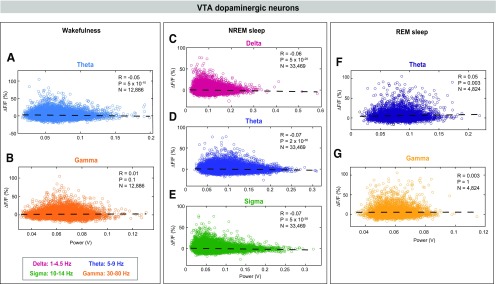
Correlations between EEG spectral components and VTA-dopaminergic neural activity during wakefulness, NREM sleep, and REM sleep. VTA-dopaminergic population activity plotted against EEG θ (A) and γ (B), power during wakefulness. VTA-dopaminergic population activity plotted against EEG δ (C), θ (D), and σ (E) power during NREM sleep. VTA-dopaminergic population activity plotted against EEG θ (F) and γ (G) power during REM sleep. Each dot represents a 1-s epoch. Dashed line is the best linear fit. R is correlation coefficient.